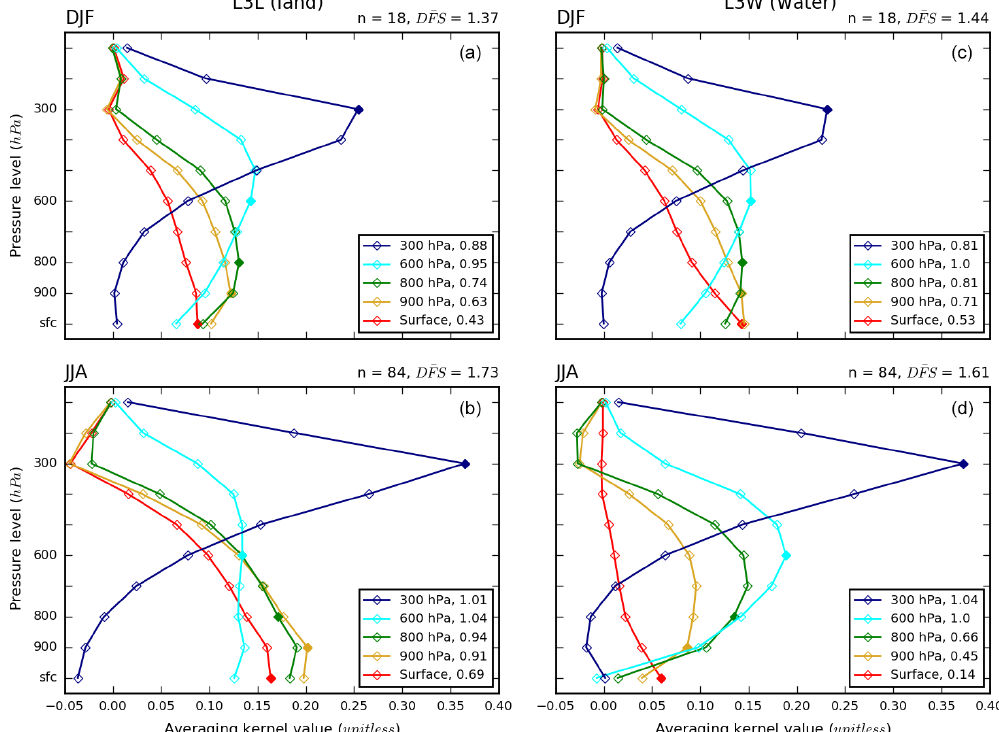
Figure 3. Mean retrieval averaging kernel (AK) rows and DFS values for L3L (land, a, b ) and L3W (water, c, d ) in DJF (a, c) and JJA (b, d) , for selected profile levels only. Filled diamonds indicate the diagonal value location for that AK. Numbers in legend indicate the correspond- ing retrieval level of AK and show the mean rowsum for that AK